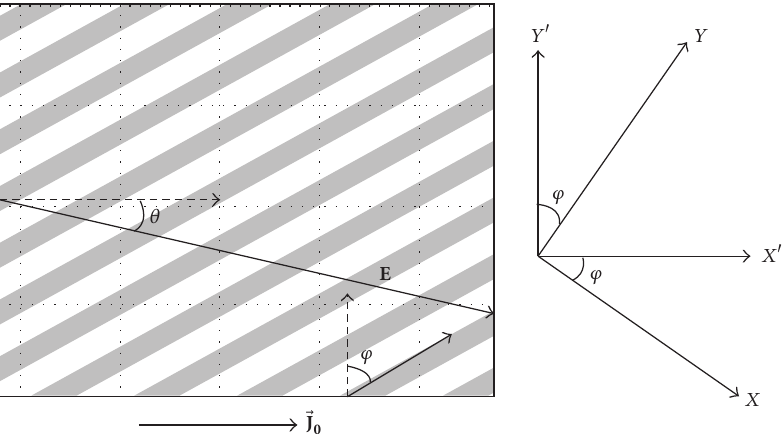
Figure 1: Cross section of the multilayer composite in the 𝑥 󸀠 𝑦 󸀠 -plane with layers rotated on angle 𝜑 around the 𝑧 -axis. 𝜃 is the bending angle of dc electric field. The 𝑥 -axis is perpendicular to the plane of the